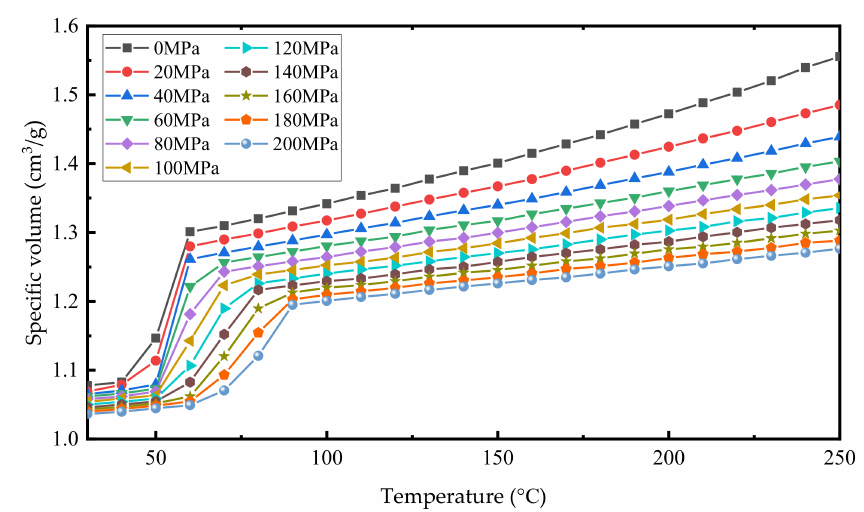
Figure 1. Specific volume for n-tetracosane (C 24 H 50 ) as a function of temperature for pressures between 0 and 200 MPa. Data from Zoller and Walsh